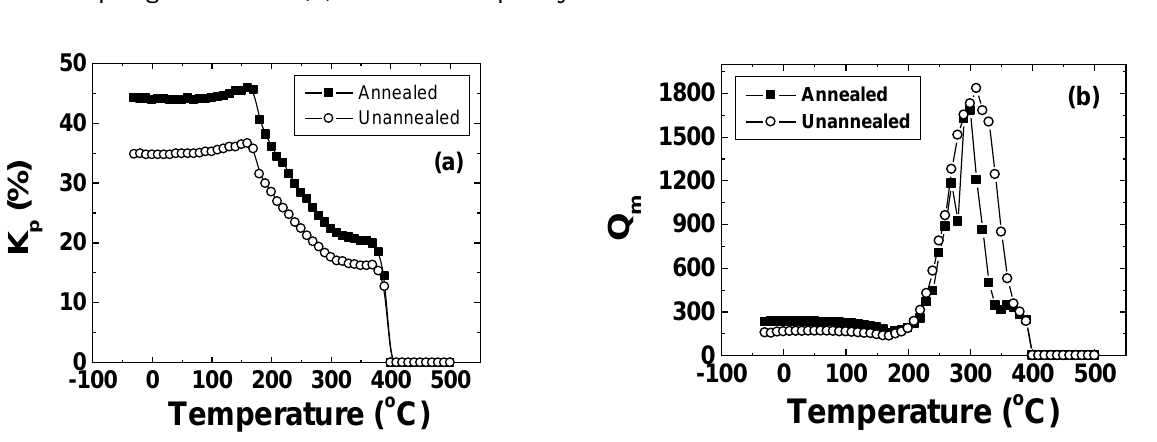
Figure 3. Temperature dependence of piezoelectric properties for KNN. (a) Radial mode coupling factor and (b) Mechanical quality